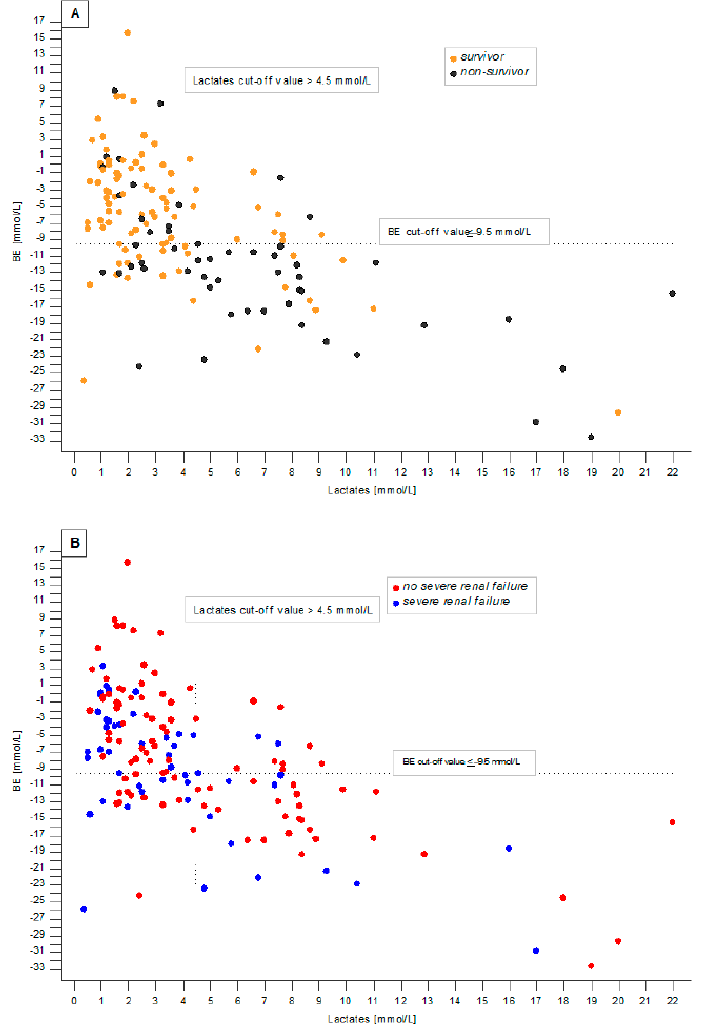
Figure 3. Association between BE value and lactate concentration in all patients, with a horizontal line for the BE cut-off and a vertical line for the lactates cut-off. In this way, four quadrants are presented. Patients in category 0 are in the upper left quadrant, and those from category 2 are in the bottom right quadrant. Individuals from category 1 are either in the upper right or bottom left quadrants. The same association is shown in both panels ( A , B ). However, in panel ( A ), patients are marked according to their ICU survival status at the end of the 28-day follow-up, whereas in panel ( B ), patients are marked according to the presence of severe renal failure, i.e., eGFR < 30 mL/min/1.73 m 2 . Associations between creatinine concentration or eGFR and BE, aBE, and lactate concentration are shown in Table 4. Lactate concentration was found not to correlate with either creatinine or eGFR, whereas BE and aBE were significant, although weakly related. Worsening of renal function was associated with deteriorating acidosis, regardless of whether BE or aBE was